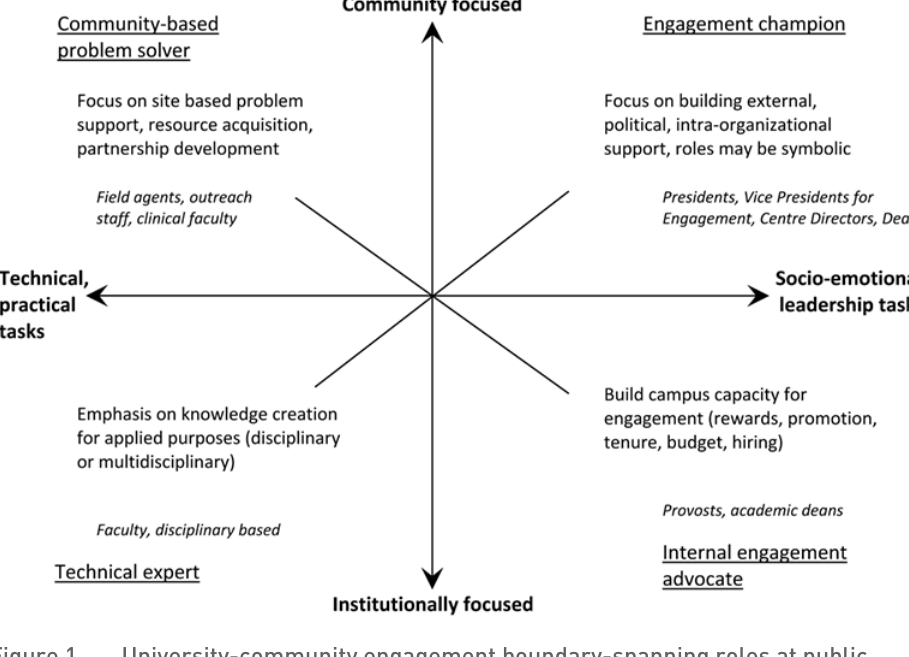
Figure 1 University-community engagement boundary-spanning roles at public research universities (Weerts & Sandmann 2010, p.